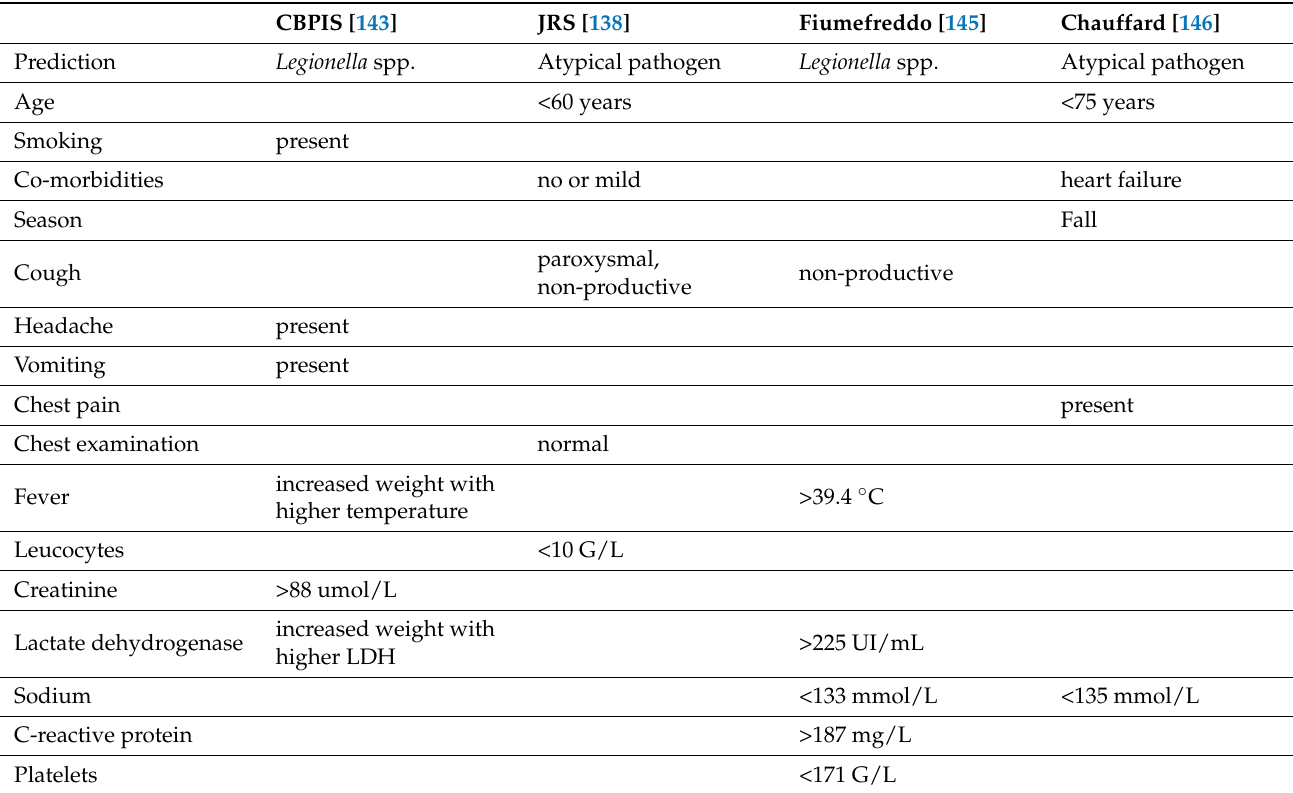
Table 3. Clinical prediction rules for legionellosis or atypical